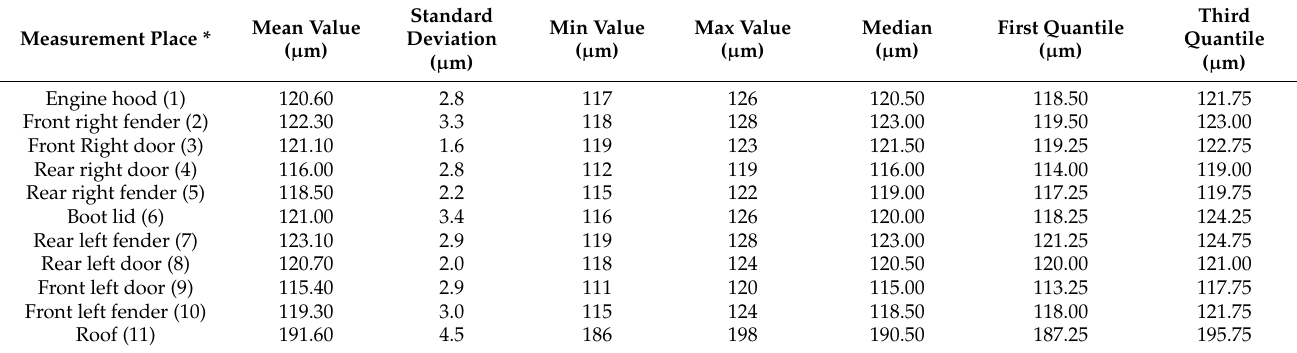
Table 1. The results of the measurements of the coating thickness on the vehicle from segment B.